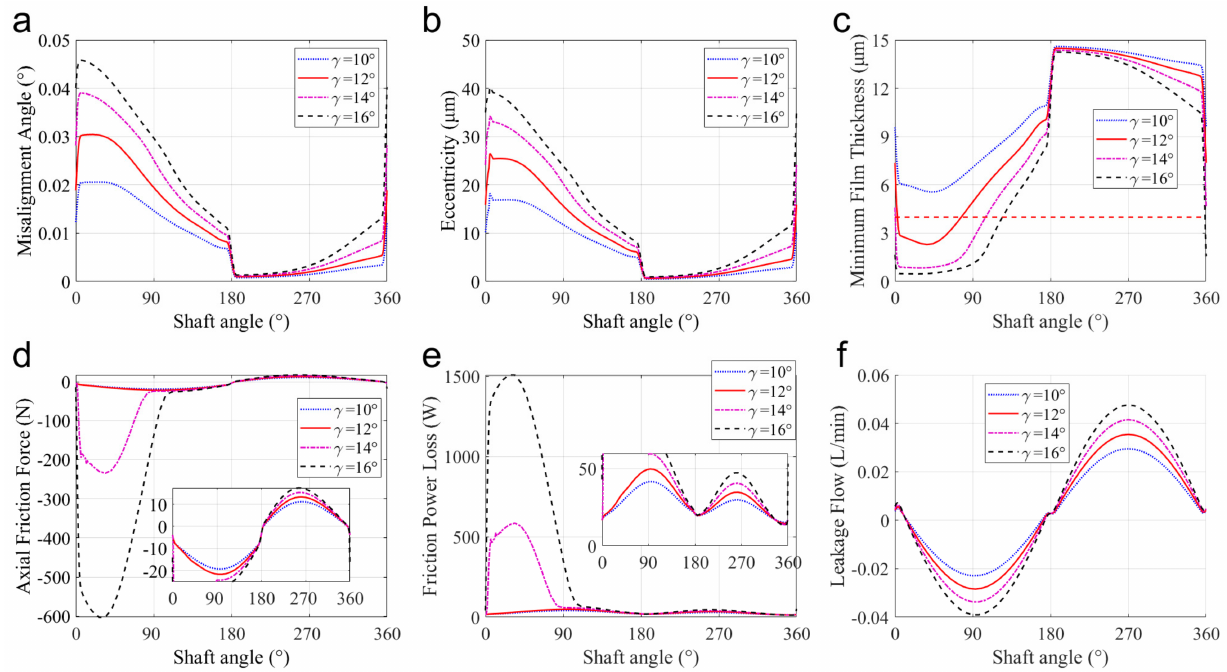
Figure 17. The effects of tile angles of the swash plate on: ( a ) the misalignment angle, ( b ) the eccentricity, ( c ) the MOFT, ( d ) the axial friction force, ( e ) the friction power loss, and ( f ) the leakage